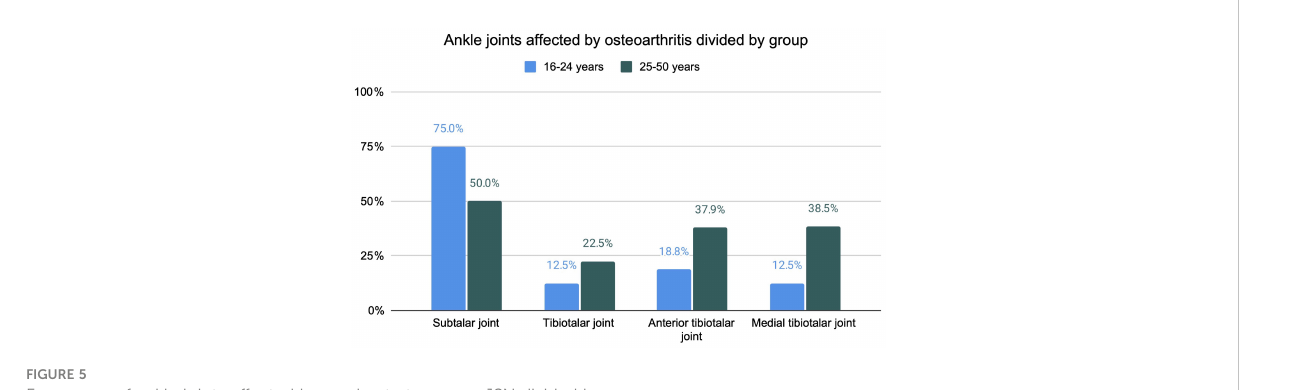
FIGURE 5 Frequency of ankle joints affected by moderate to severe JSN divided by